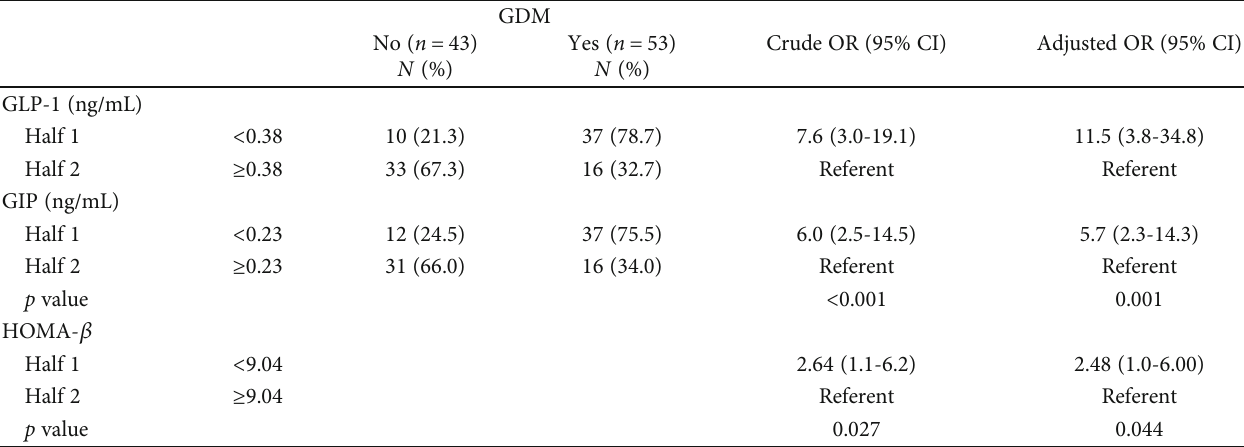
Pairwise analysis comparison (Bonferroni post hoc adjustment) following one-way ANOVA or Kruskal – Wallis test. a p value < 0.05 compared to examination 1. b p value < 0.05 compared to examination 2. c p value < 0.05 compared to examination 3. † p value < 0.05 compared to GDM-diet. ∗ p value < 0.05 compared to control. Table 4: Binary logistic regression analysis for the prediction of gestational diabetes mellitus ( n = 96